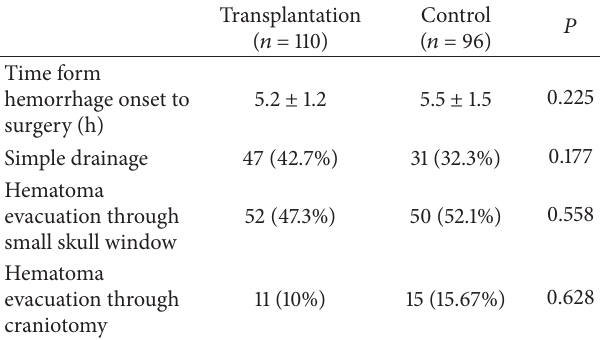
Table 2: Comparison of surgical management.